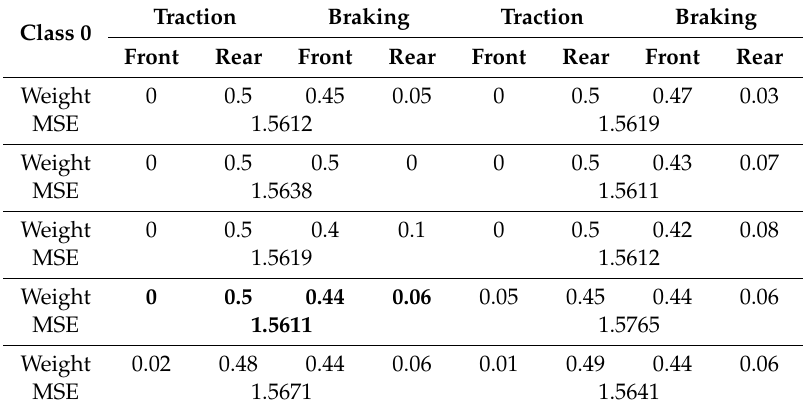
Table 6. Weight selection of Weighted Average in Class 0 state.